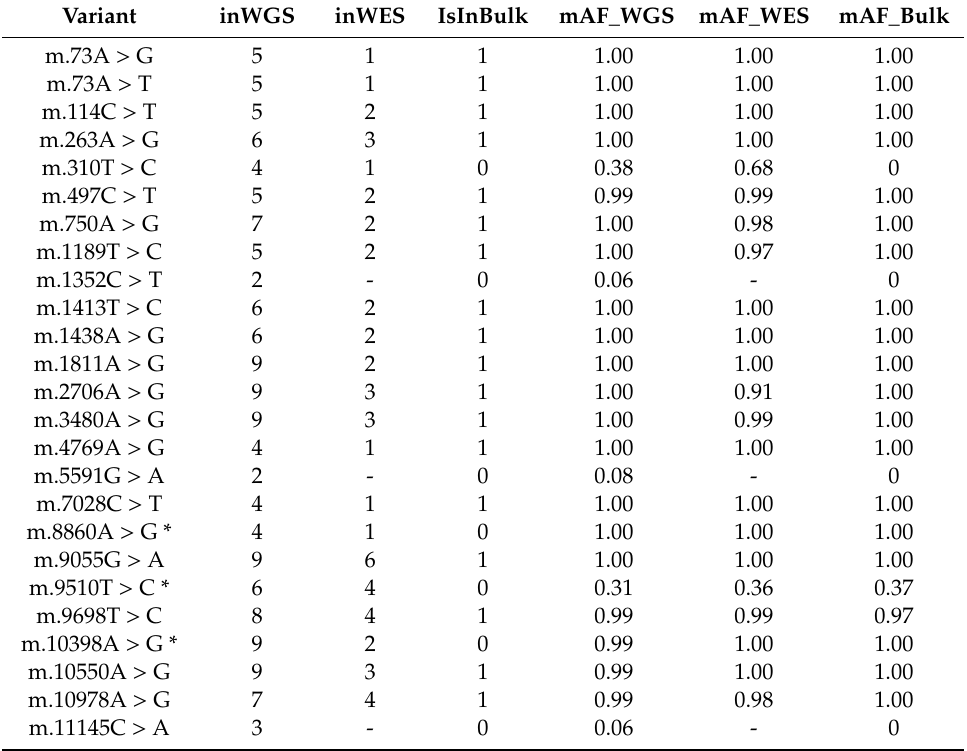
Table 2. Variants detected in nine HT-29 cells sequenced using the eWGA protocol according to the following thresholds: depth of 30 reads and minimum allele frequency of